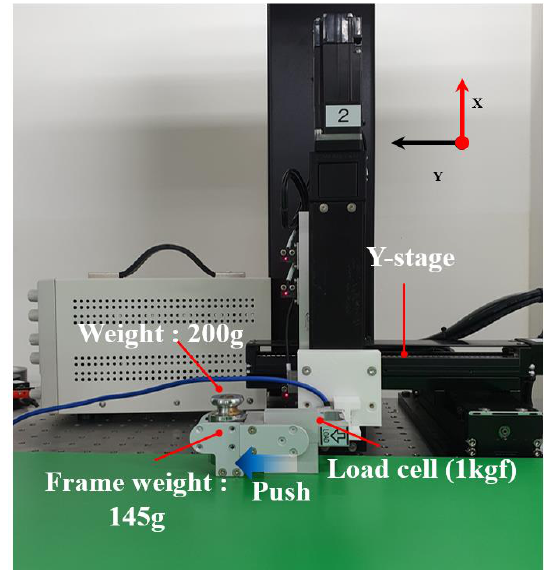
Figure 10. Experiment setup for measuring the friction coefficient.